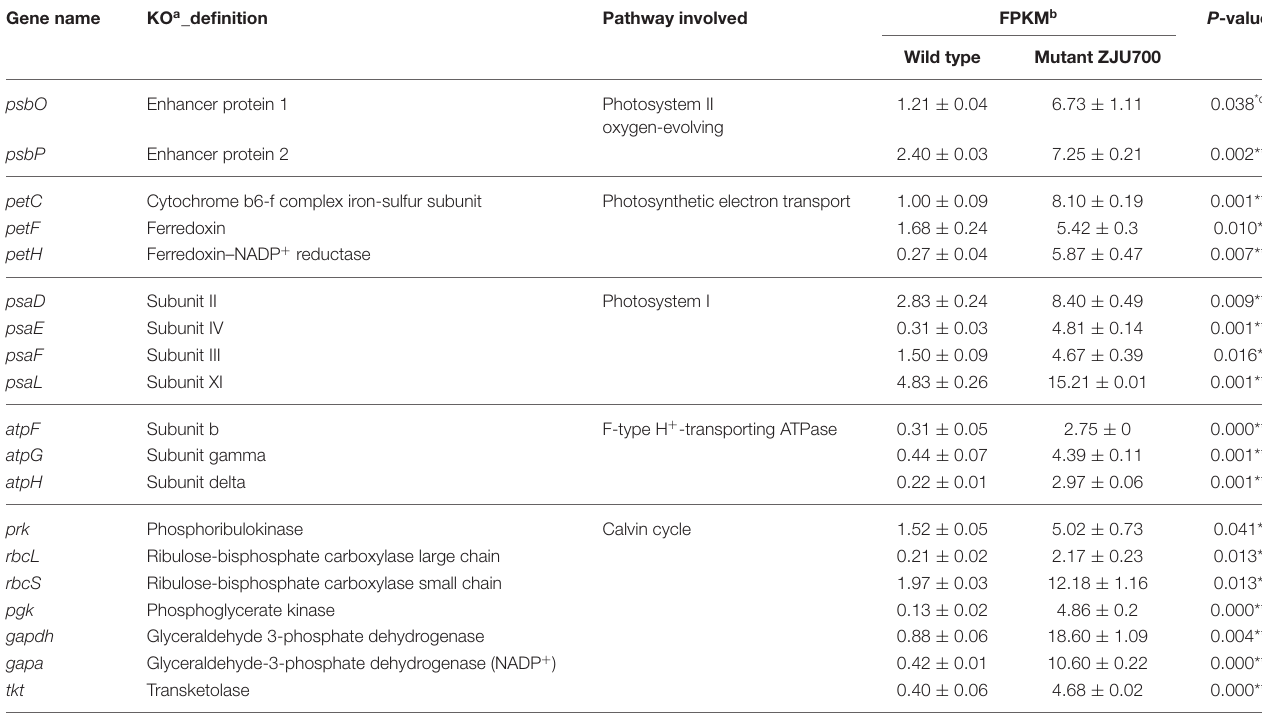
FIGURE 4 | Up-regulation of photoreaction-related genes in the Nannochloropsis mutant ZJU700 after nuclear radiation. Yellow ovals represent protein complexes with up-regulated genes. One red upward arrow means that log 2 (fold change of up-regulated gene expression) is higher than 1, two red upward arrows means that log 2 (fold change of up-regulated gene expression) is higher than 2, etc. (A) Photosystem II complex; (B) Cytochrome b6/f complex; (C) Photosystem I complex; (D) ferredoxin and ferredoxin-NADP+reductase; (E) ATP synthase complex. TABLE 1 | Annotation and regulation of differentially expressed genes related to the photoreaction and Calvin cycle in the Nannochlorpsis mutant